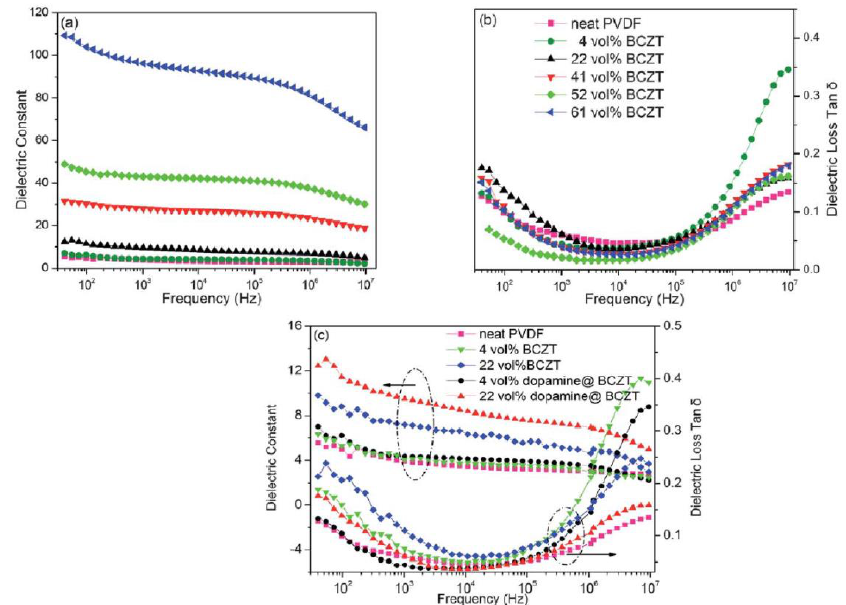
Figure 14. Frequency dependence of the dielectric constant ( a ) and the dielectric loss tangent, ( b ) of dopamine@BCZT / PVDF composite films, and ( c ) BCZT / PVDF (Poly(vinylidiene fluoride)